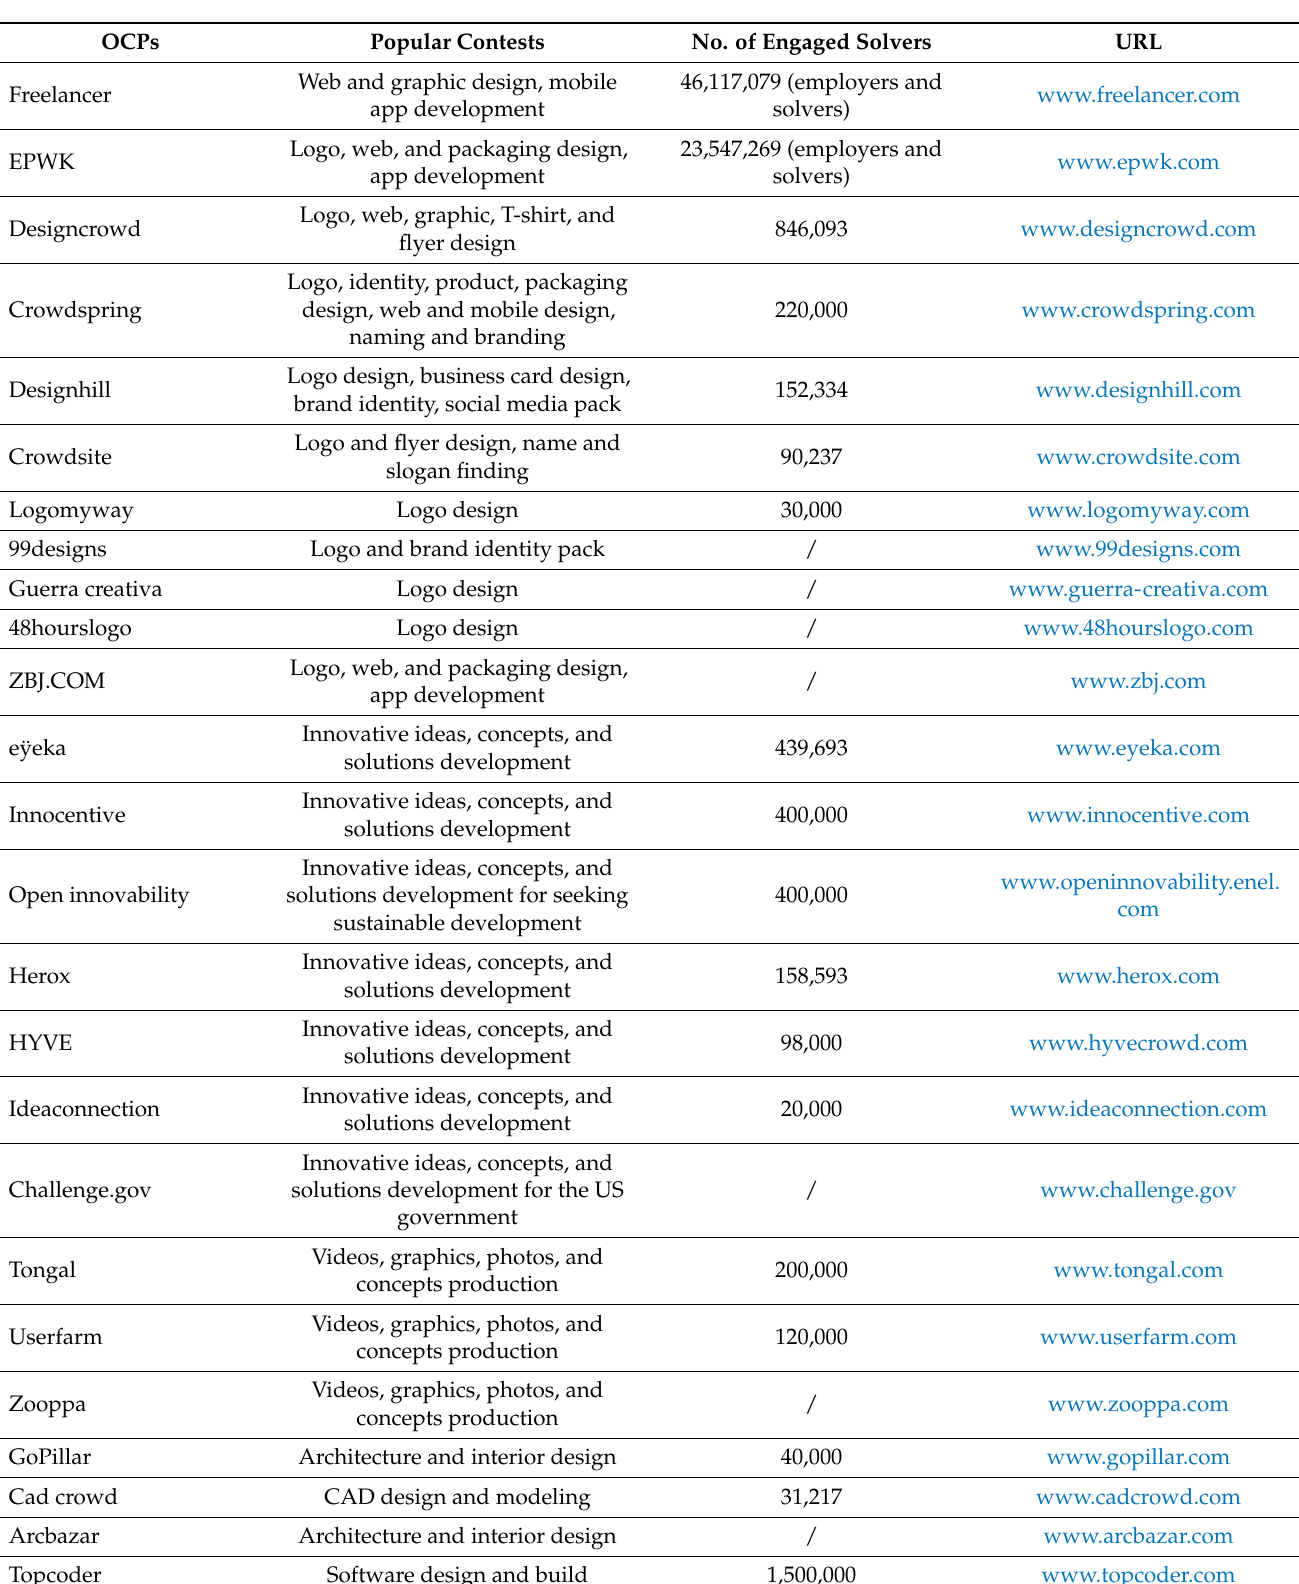
Table 1. The selected